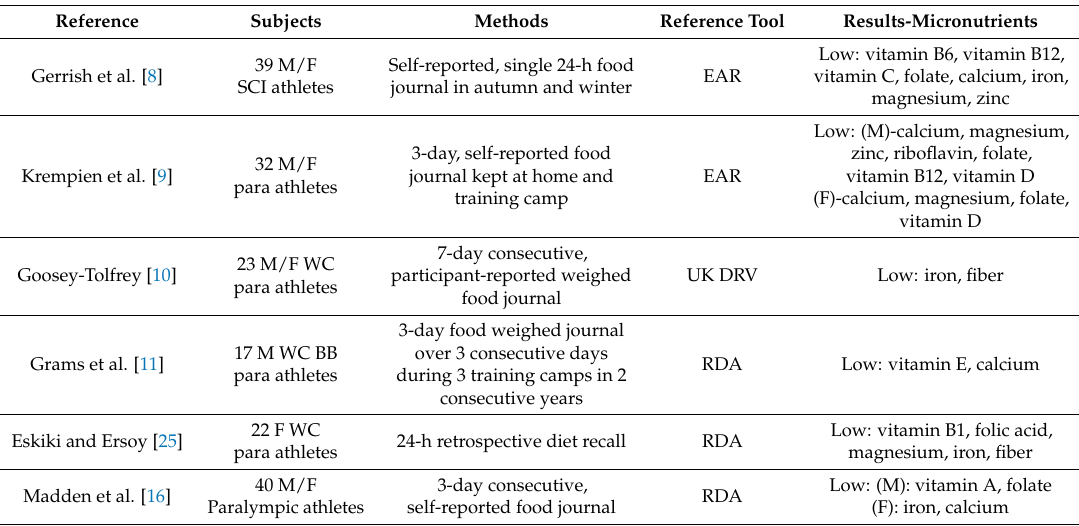
Table 4. Overview of studies examining micronutrient intake of para athletes, including athletes with